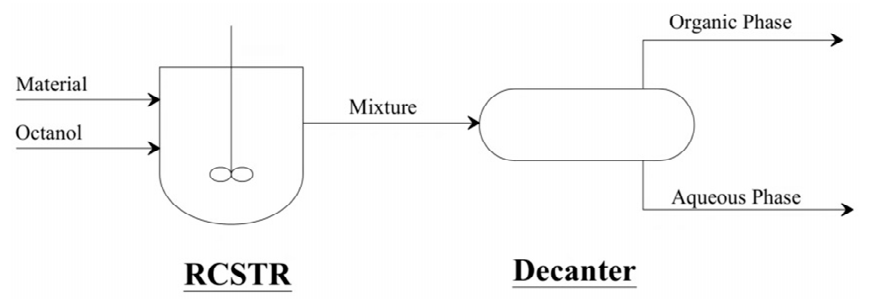
Figure 10. Reaction extraction simulation equipment diagram.